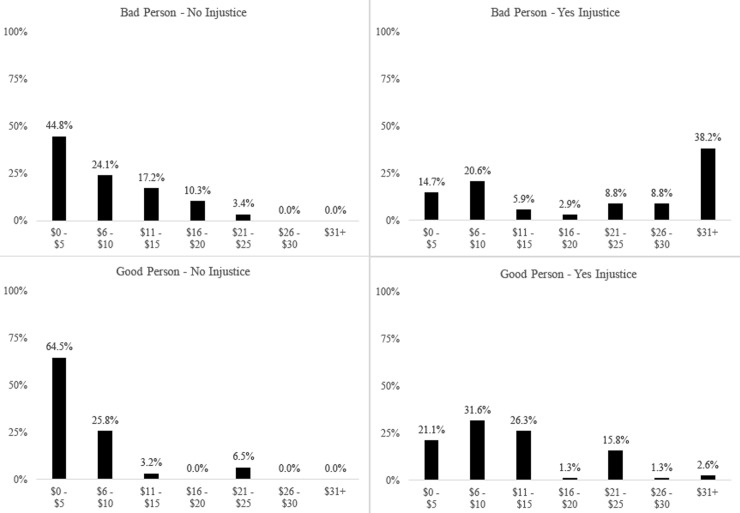
Study 1: Histogram of spending amounts by those who spent anything to compensate or punish, by condition.